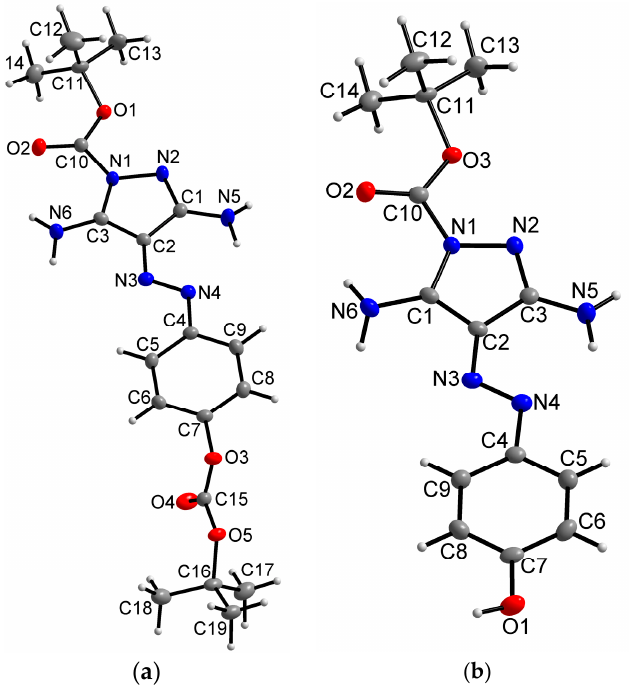
Figure 2. Molecular structures: ( a ) pyrazole 3 (CCDC 1453321) and ( b ) pyrazole 5 (CCDC 1453320), together with the atom numbering schemes. The thermal ellipsoids of the non-hydrogen atoms are drawn at the 50% probability level.